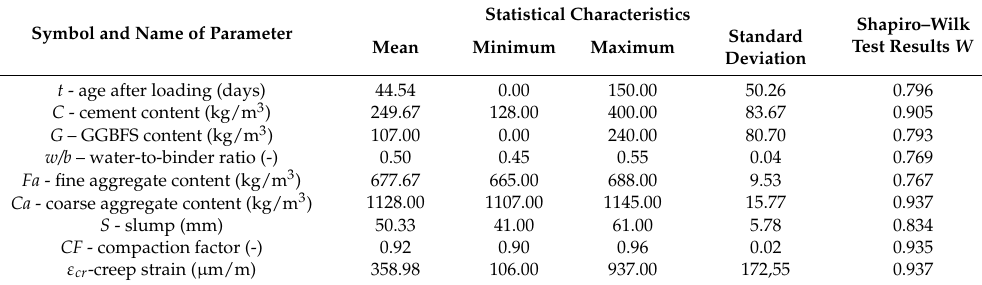
Table 5. Statistical characteristics of the